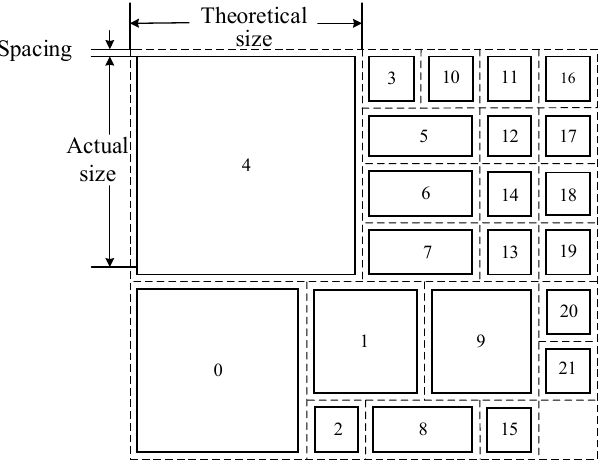
Figure 1. Schematic diagram of the actual and theoretical dimensions of chiplet 4. Table 1. The actual sizes and the theoretical sizes of chiplets.